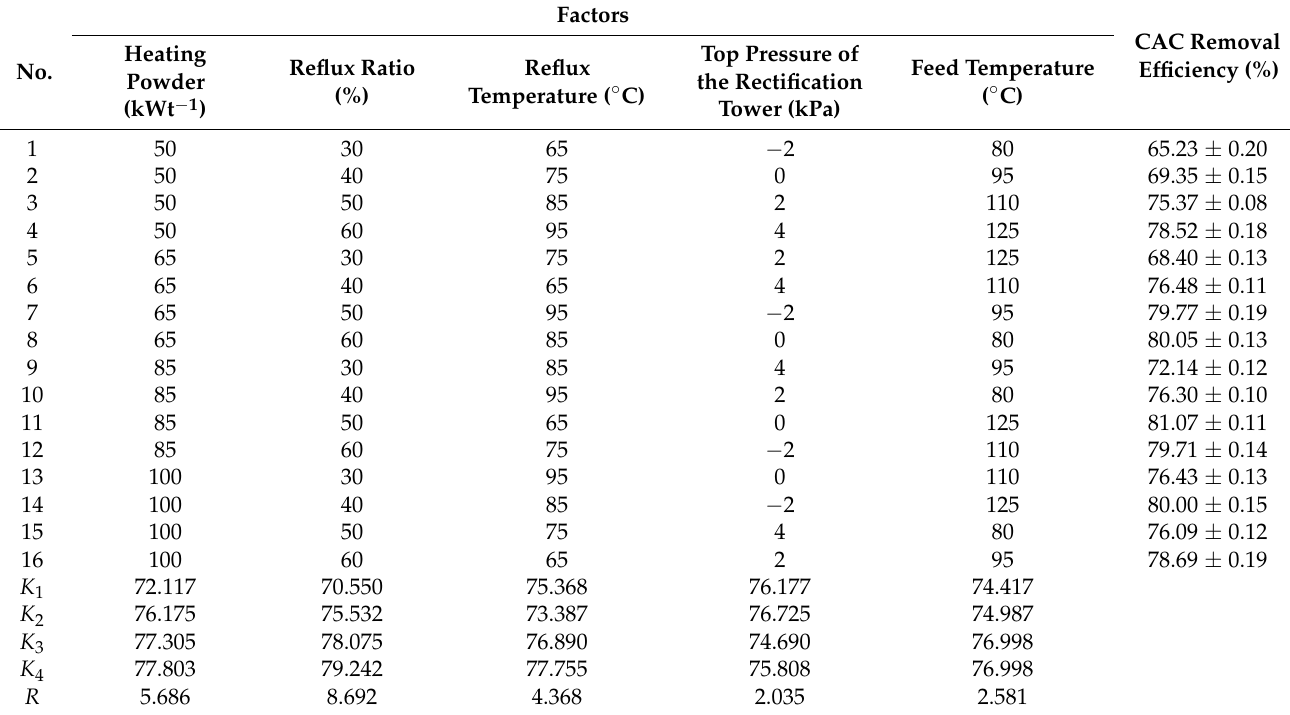
Table 5. L 16 (4 5 ) orthogonal design of the experiment and